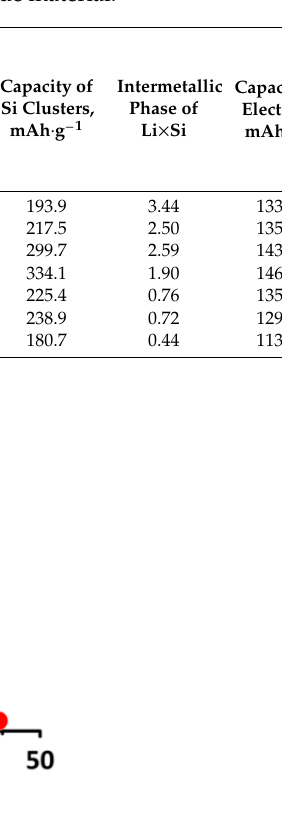
Table 2. Parameters of model II as the battery anode material.